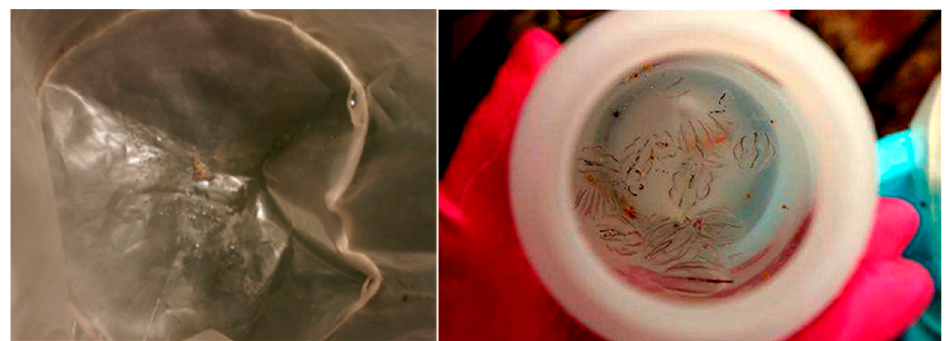
Figure 12. Samples in the trawl net and sample tube #3.